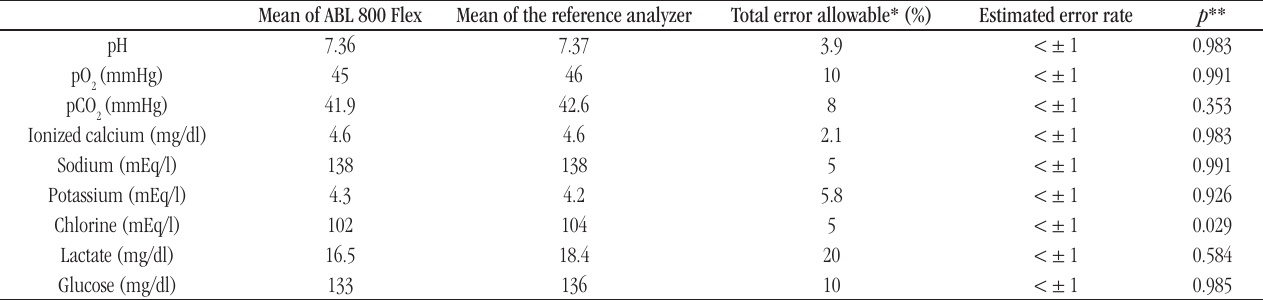
taBLE 4 − Results of comparison between data obtained from ABL 800 Flex instruments and the reference